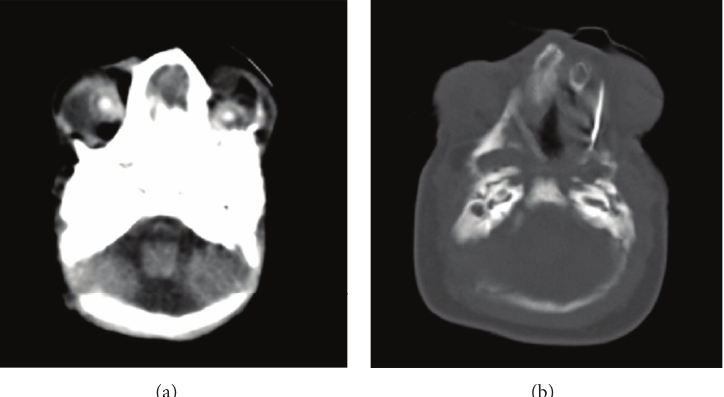
Figure 3: Computed tomography of the cranium, in the axial plane, showing severe hypoplasia of the maxillary bones (a), which were dysmorphic and covered with skin